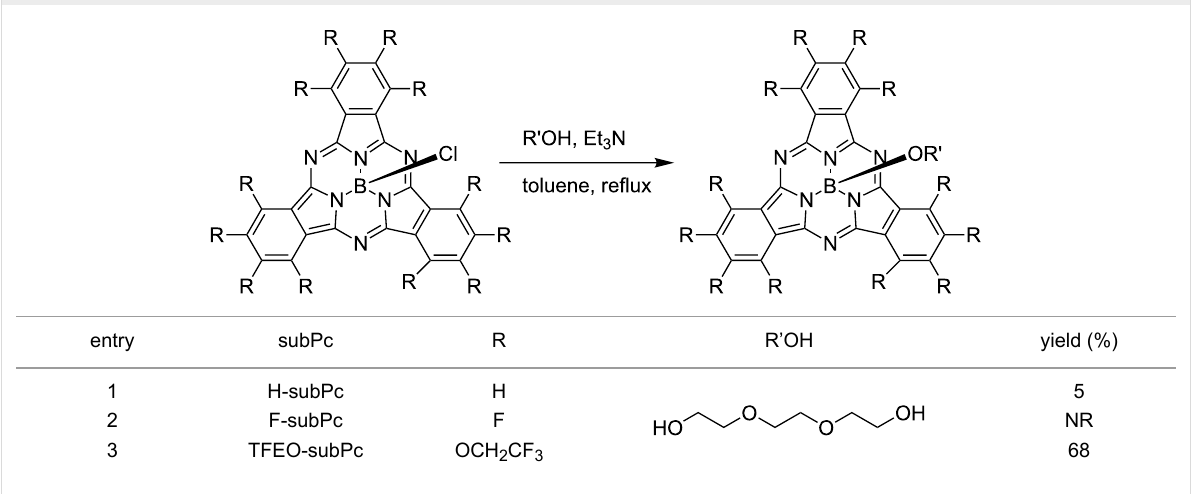
Table 4: Comparison of axial ligand substitution reactivity of